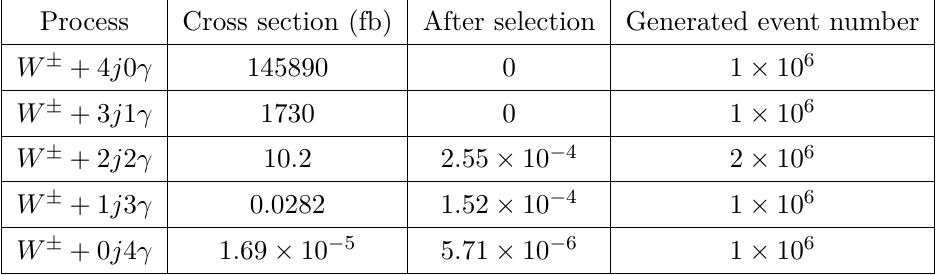
√ s = 13 TeV are given, after taking into